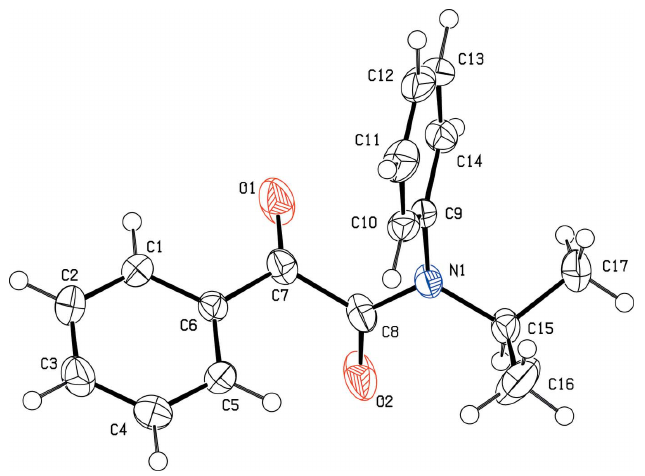
Figure 2 The molecular structure of the title compound 1c . Displacement ellipsoids for non-H atoms are drawn at the 50% probability level.